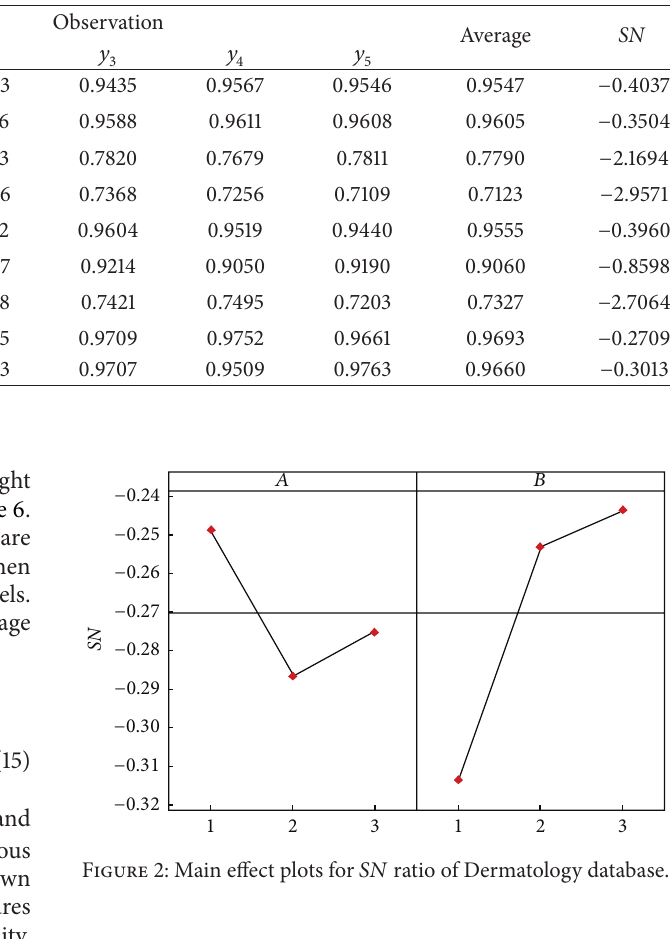
Table 7: Summary of experiment data of Zoo database.